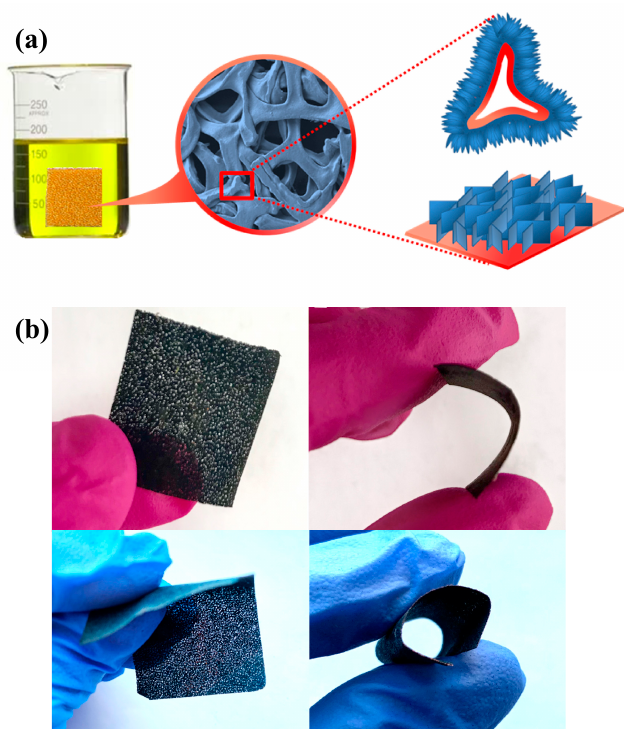
Figure 6. ( a ) Schematic diagram of the CuS formation process on the surface of Cu foam. ( b ) Flexibility test of CuS formed on Cu foam.